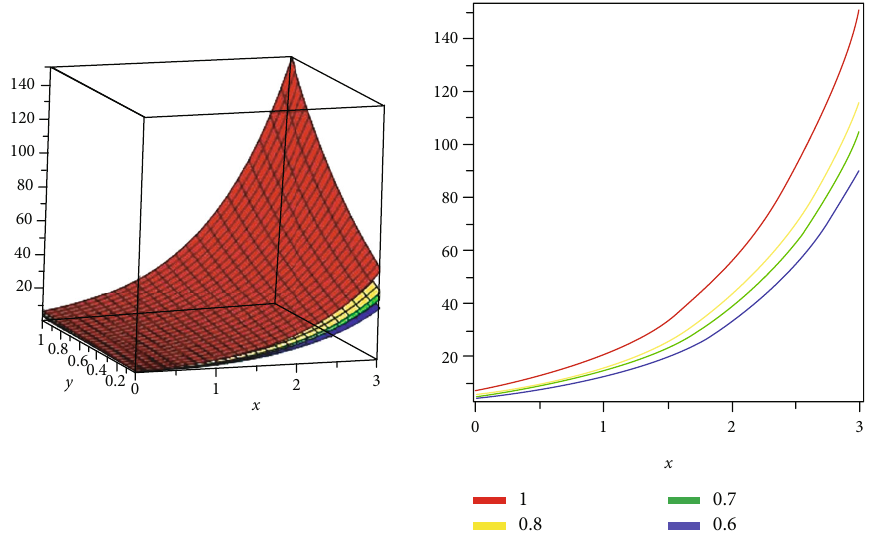
Figure 6: The di ff erent fractional-order graphs of δ Problem 3.3.